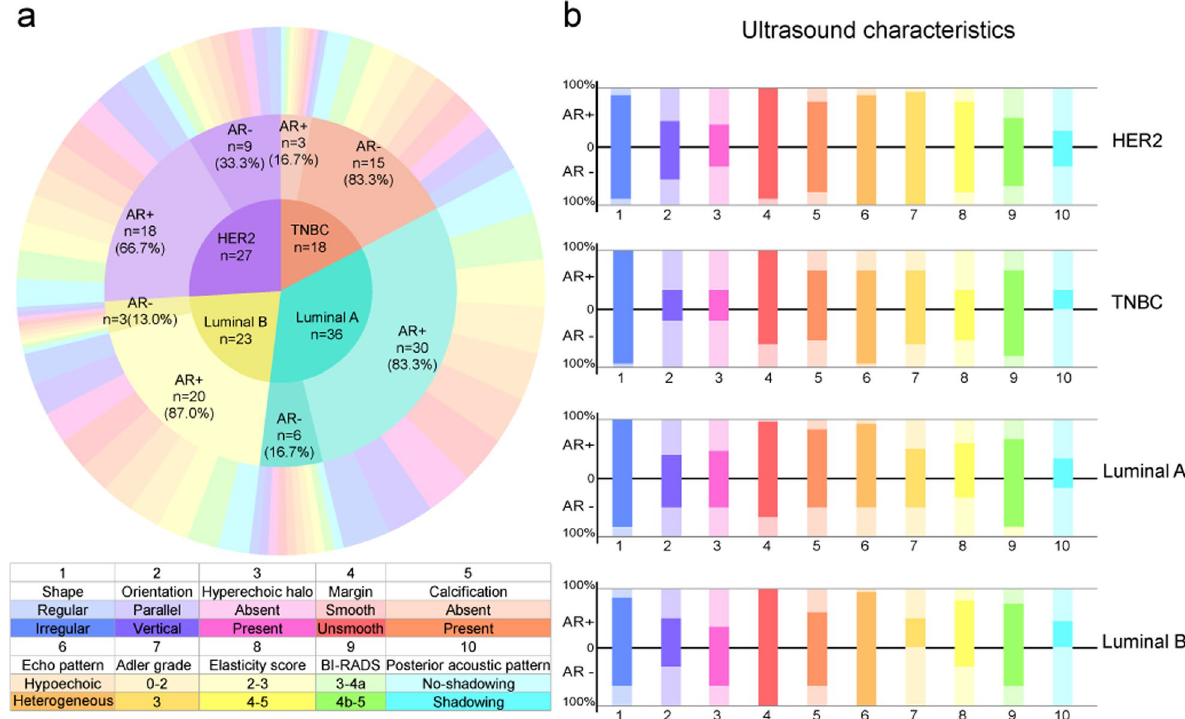
Fig. 4 Comparison of ultrasound characteristics between AR– and AR molecular subtypes. b The distribution differences of ultrasound characteristics between AR– and AR Luminal A and Luminal B subtypes, respectively. TNBC , triple negative breast cancer; HER2 , human epidermal growth factor receptor 2; AR , androgen receptor; BI-RADS , Breast Imaging Reporting and Data